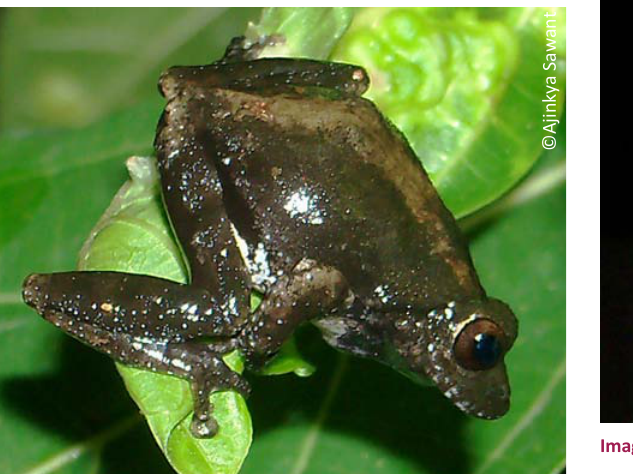
Image 11. Raorchestes bombayensis